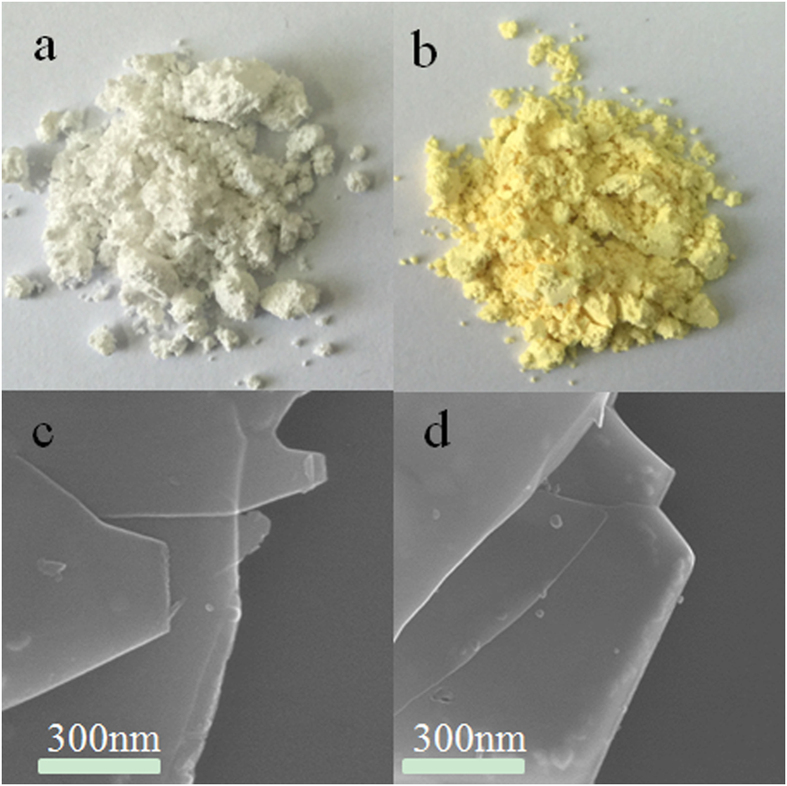
Photo(a,b) and FE-SEM(c,d) of the HTO crystals (a,c)before and (b,d)after the treatment in H2O2 solution, respectively.